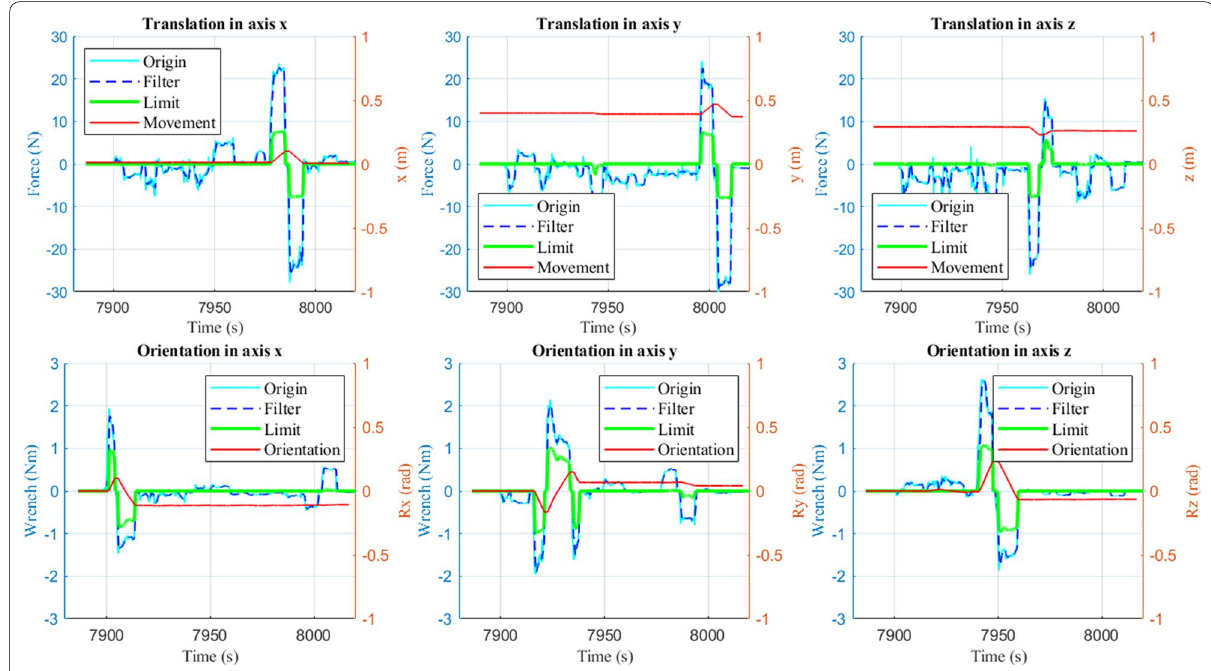
Figure 7 The results of the first experiment with full dimension